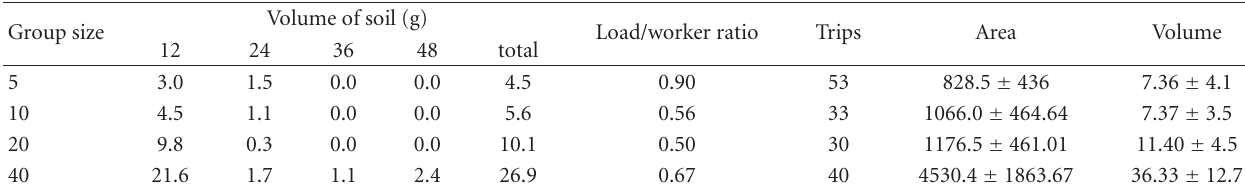
Table 1: Digging rate (g), area excavated (mm 2 ), and volume of soil excavated (cm 3 ) by groups of workers (5, 10, 20, and 40), as a function of elapsed time.